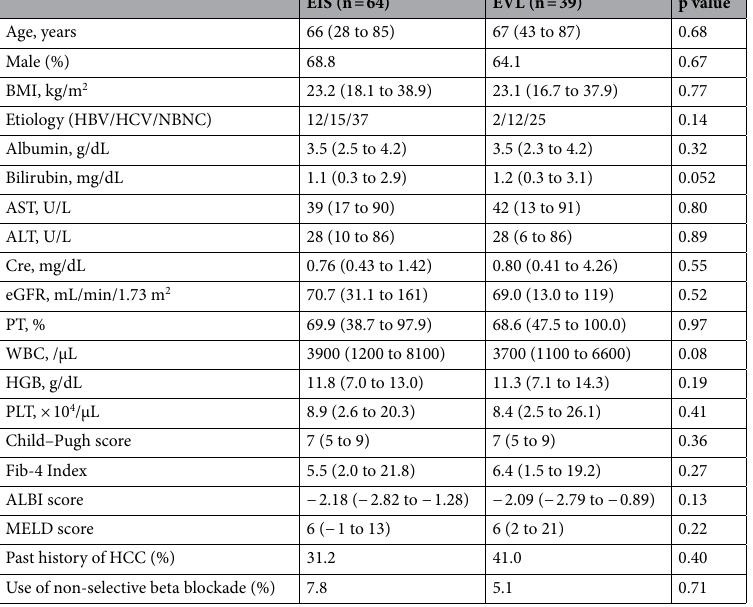
Table 1. Baseline characteristics in EIS and EVL group. p values are results that compared EIS group with EVL group. Categorical variables were analyzed using χ 2 -test or Fisher’s exact test, and continuous variables were compared using Mann–Whitney’s U test. alfa fetoprotein, ALBI albumin–bilirubin, AST aspartate transaminase, ALT alanine aminotransferase, BMI body mass index, Cre creatinine, eGFR estimated glomerular filtration rate, EIS endoscopic injection sclerotherapy, EVL endoscopic variceal ligation, HBV hepatitis B virus, HCC hepatocellular carcinoma, HCV hepatitis C virus, HGB hemoglobin, MELD the model for end-stage liver disease, NBNC non-hepatitis B virus and non-hepatitis C virus, PLT platelet, PT prothrombin time, WBC white blood cell.